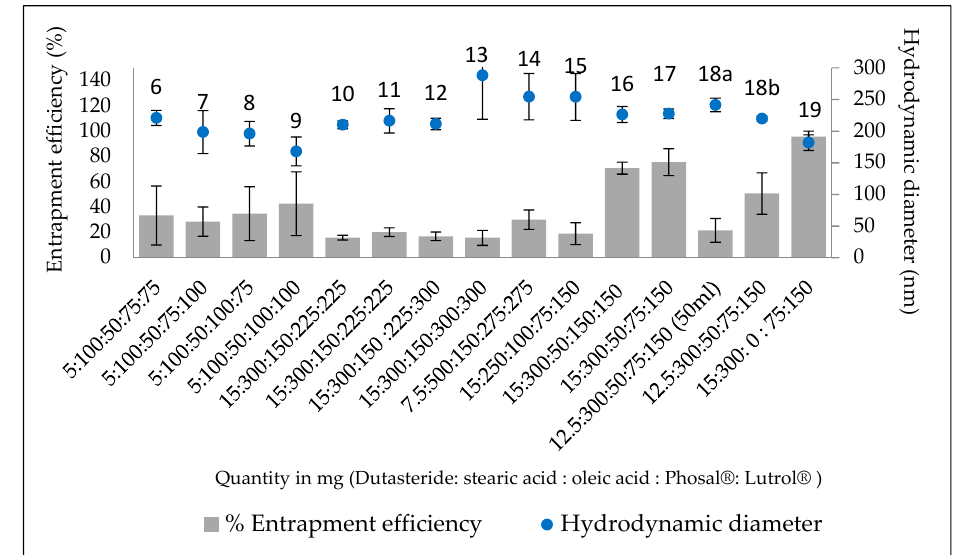
Figure 1. Entrapment efficiency (%EE) and hydrodynamic diameter size of LNP with altered ratios of components for Formulations 6–19.